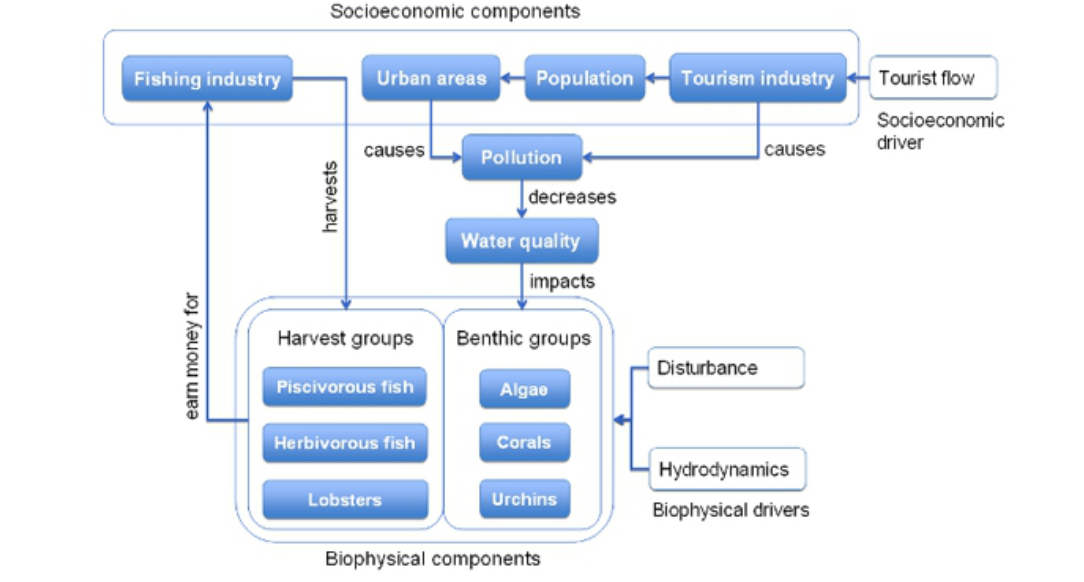
Fig. 3. Coupled model components and drivers. Key information flows between socioeconomic and biophysical modules are indicated by arrows. Tourist flow, hydrodynamics, and disturbance act as external